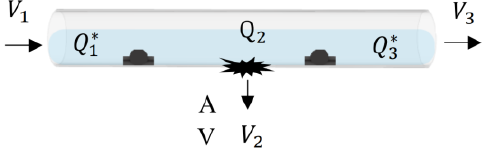
Figure 6. Schematic of broken pipeline with hall sensors and parameters. Table 1. The proportion of flowrate of hall sensor to flowrate of